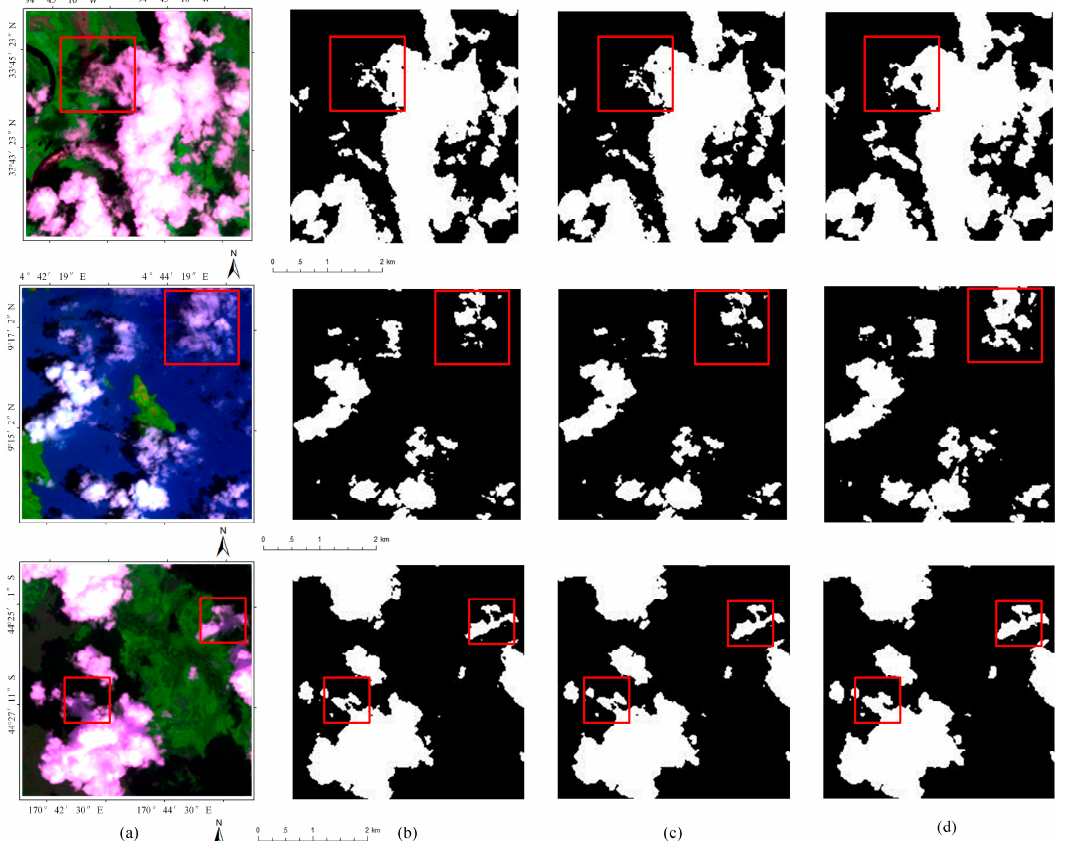
Figure 10. Visual comparisons of detection results with different fundamental features combination: ( a ) the original image with band combination 3-4-1; and ( b – d ) detected results of spectra, spectra + texture, and spectra + texture+ structure,